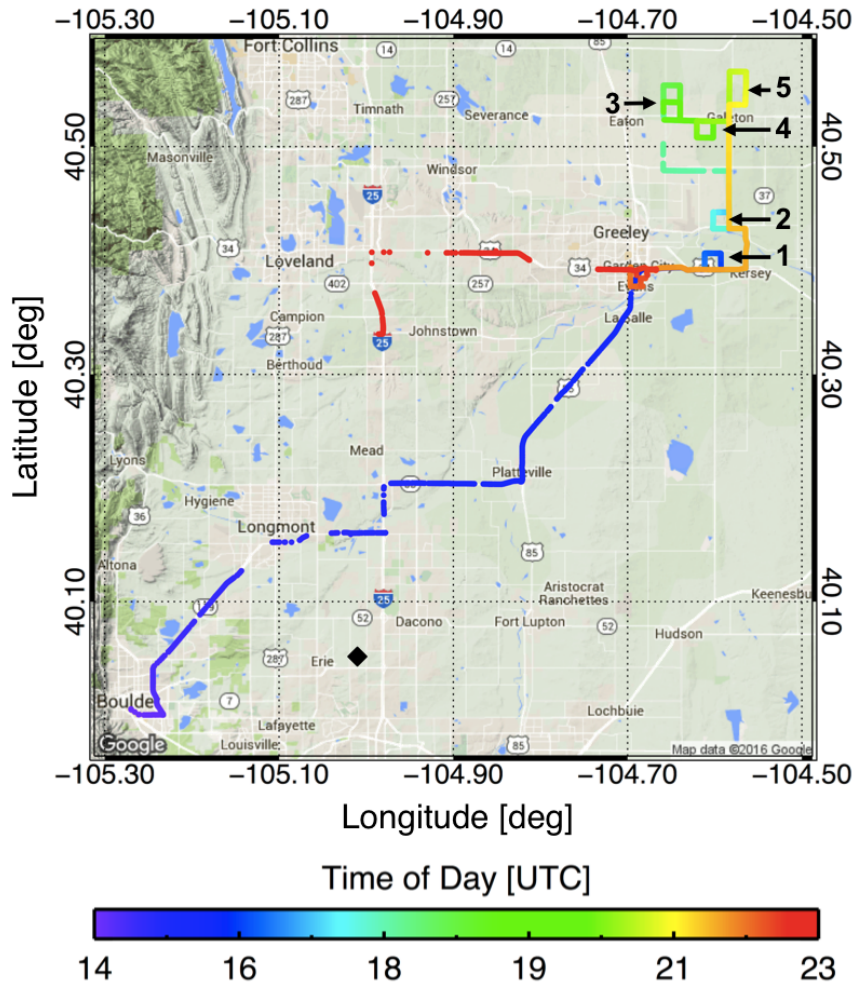
Figure 6. Research drive track of RD11 to investigate agricultural sources near Greeley, CO. Sites 1, 4 and 5 are dairy farms, 2 is a beef farm and 3 is a sheep farm. The diamond indicates the location of the BAO